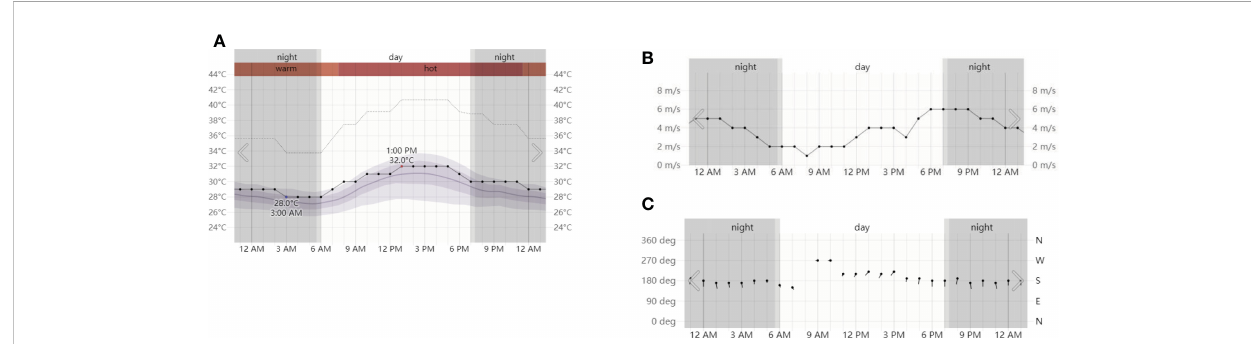
FIGURE 2 Weather conditions on the day of measurement: (A) is the temperature record; (B) is the wind speed record; and (C) is the wind direction